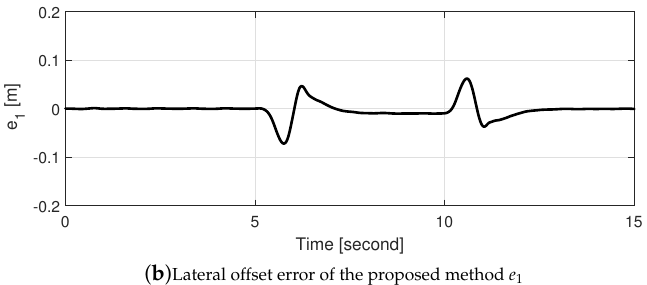
Figure 14. Lateral offset errors for the PI control and the proposed methods